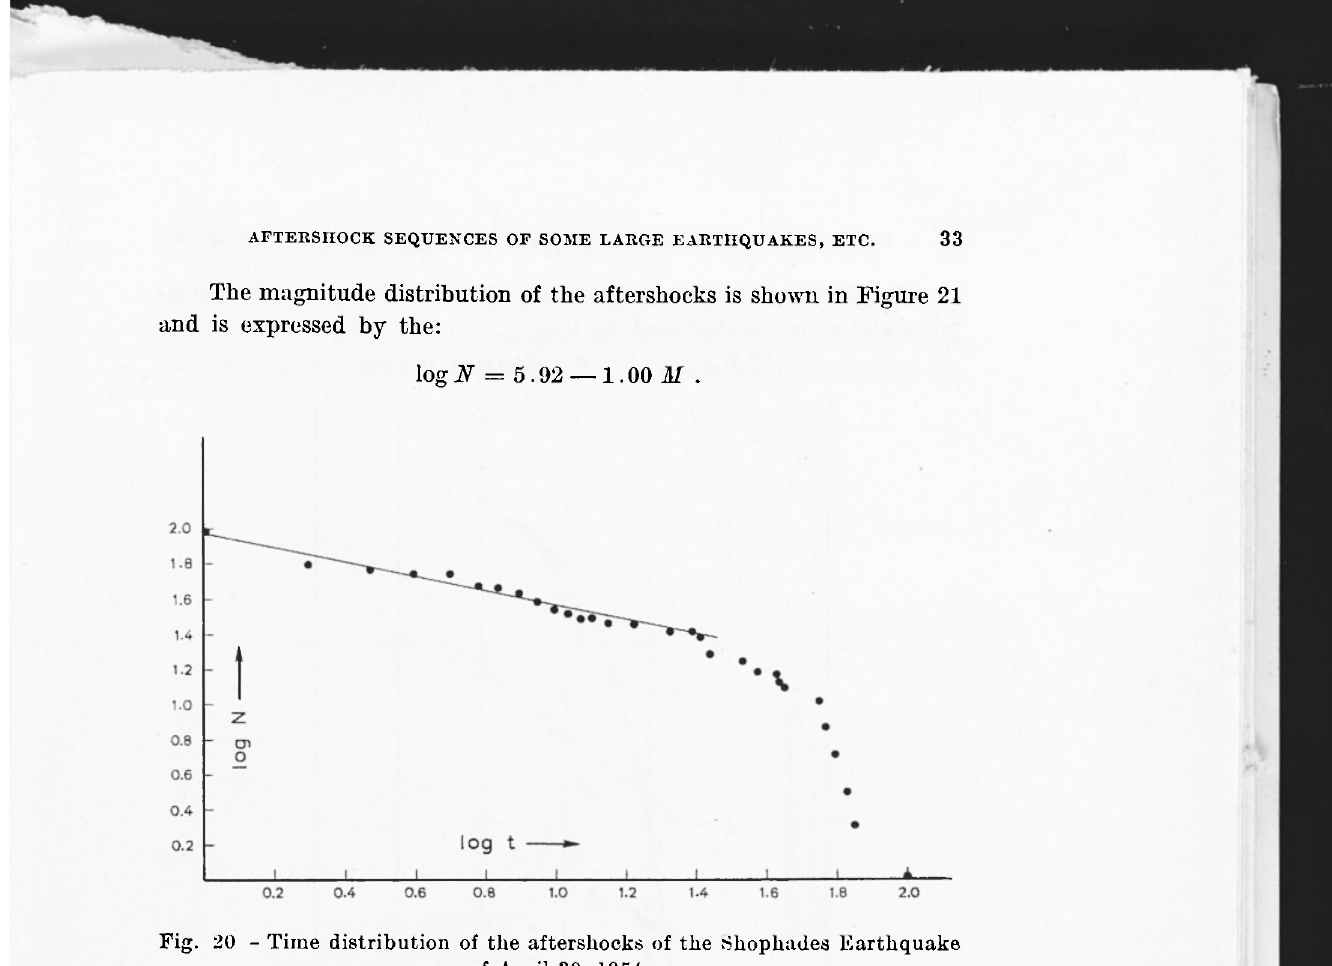
Fig. 20 - Time distribution of the aftershocks of the Shophades Earthquake of April 30, 1954.